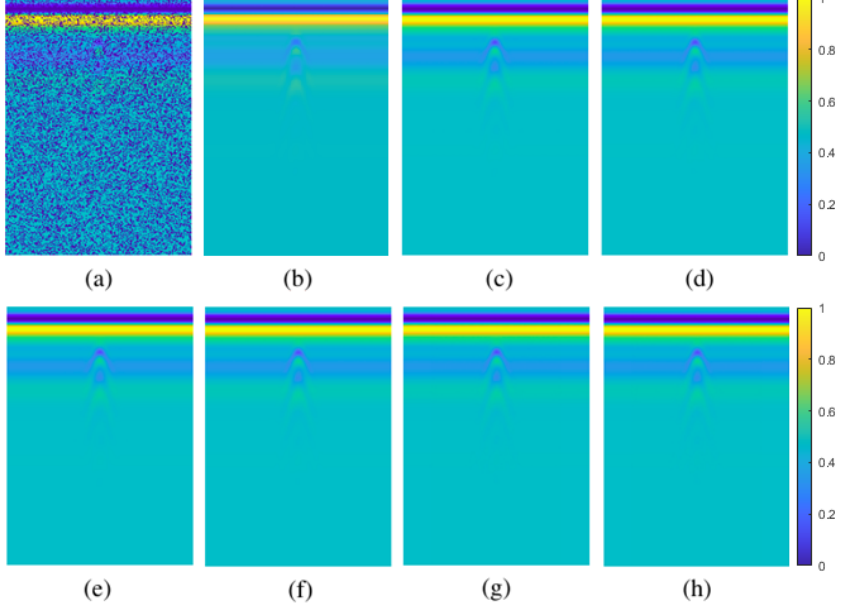
Figure 7. 30% pixel-wise missing data case for simulated data: ( a ) GPR image with missing entries, ( b ) original GPR image, recovered images by ( c ) GoDec, ( d ) NMC, ( e ) Lmafit, ( f ) NNM, ( g ) PEN-Net, ( h ) DIP.